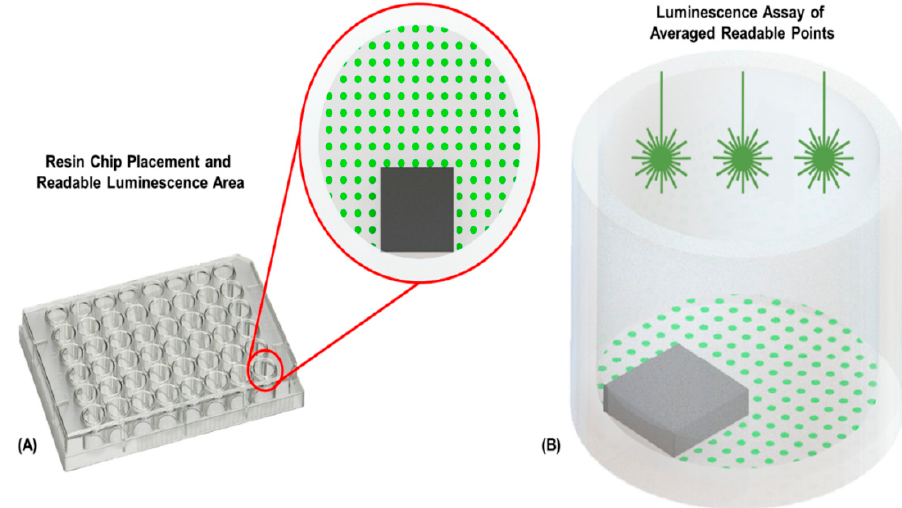
Figure 2. Luminescence assay. ( A ) Image of a 48-well plate with schematic close-up demonstrating the placement and relative size of the resin chips in the wells. The grid of green dots represents the sampling points of the luminescence assay. ( B ) Schematic view of the luminescence assay process, illustrating the averaged luminescence leading to an output of percent viability. The stars illustrate the source light hitting the surface of the liquid in the culture well.